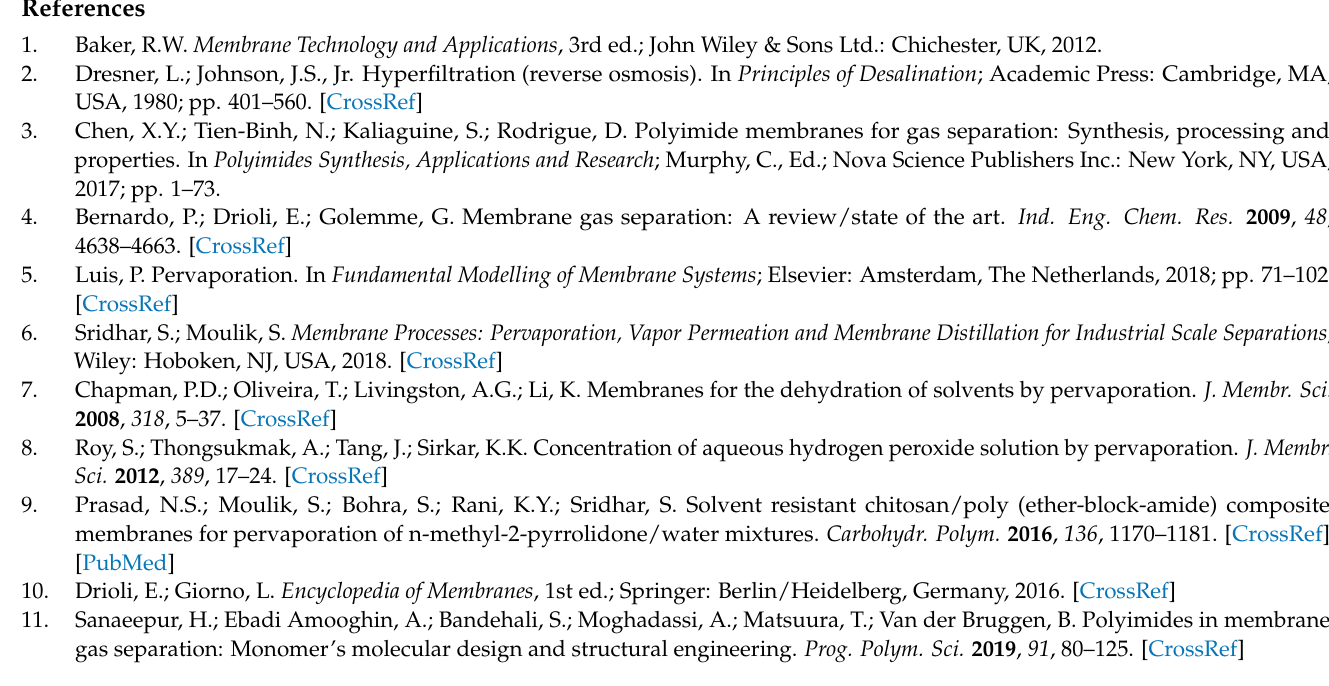
Figure S1: Pervaporation laboratory setup: AT—air thermostat, C—condenser, CG—carrier gas, D—digital pressure gauge, FC—flow controller, FS—flow switch, HE—heat exchanger, LP—liquid pump, LV—liquid vessel, MC—membrane cell, PG—pressure gauge, PR—pressure regulator, TS— temperature sensor, V—valve, VP—vacuum pump. code-examples.ipynb: Executable